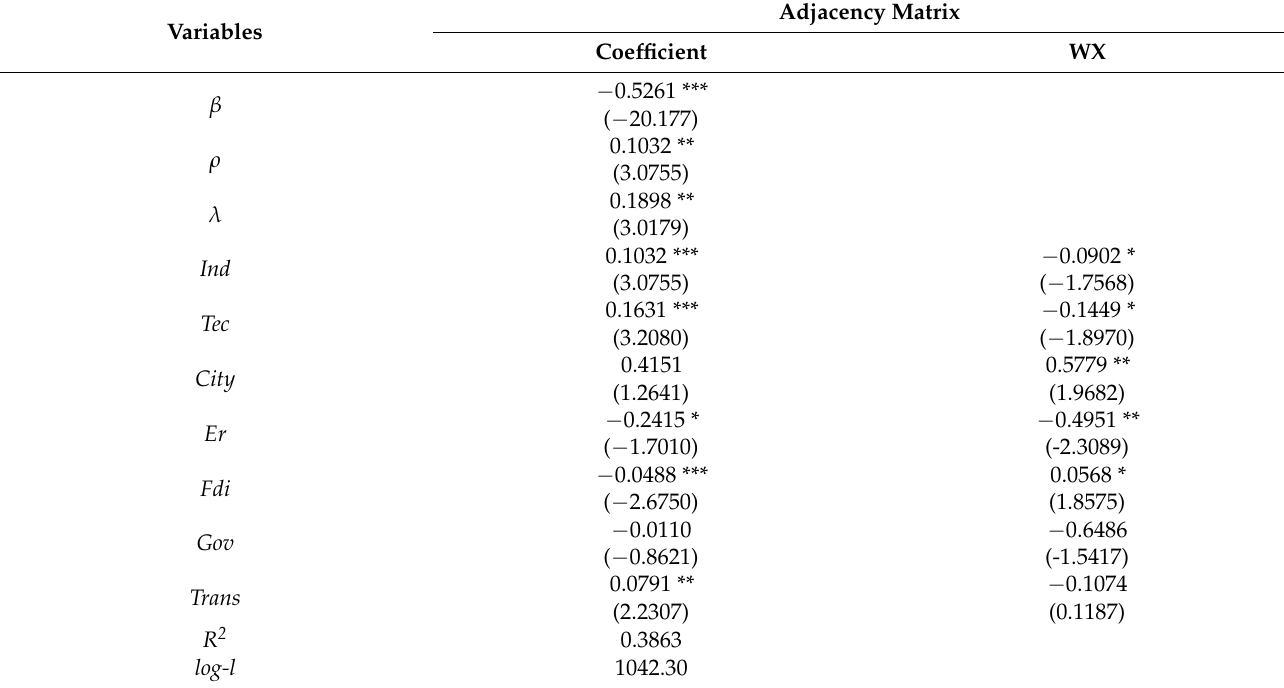
Table 7. Conditional β convergence estimation results under adjacent space weight